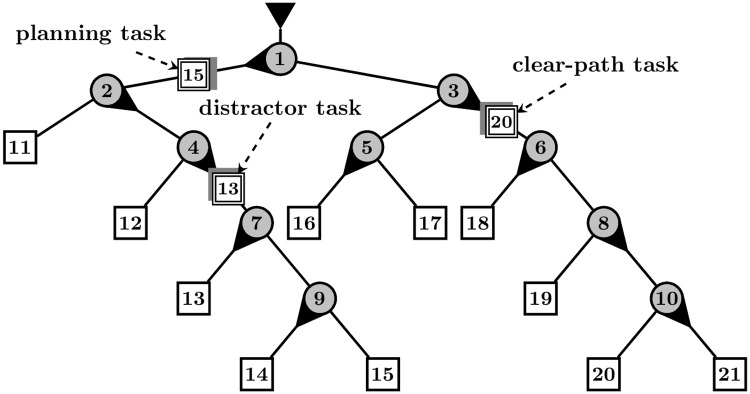
Illustration of the planning and clear-path (non-planning) game situations, and the four types of strategic decisions.The moving unit #15, having a distractor (#13) on its future path, is called a planning task; #20 is a clear-path task since its future route to be followed is clear from other tasks. The strategic decisions defined in the paper (and examples on the present illustration) are: (i) planning switch flip (flipping switch #9 for task #15), (ii) primary task selection (flipping switch #6 or #10 for task #20), (iii) within task switch flip (#6 followed immediately by #10, or in reverse order) and (iv) primary action selection (# 6 for task #20).